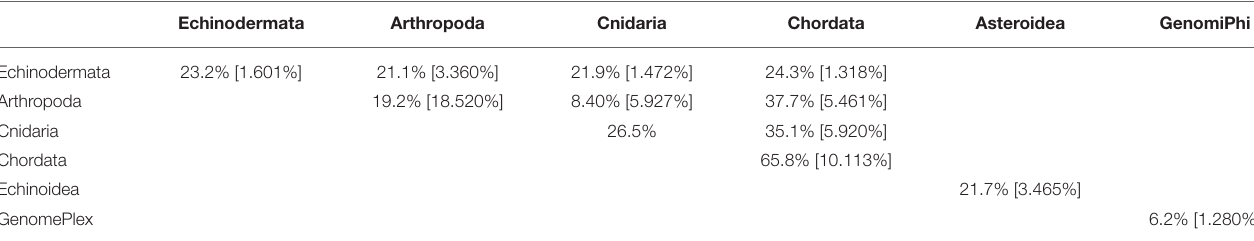
TABLE 4 | Pair-wise matrix of mean similarity and standard error (in brackets) of non-bacteriophage viromes within and between host phyla, between asteroids and echinoids, and between GenomePlex and GenomiPhi prepared libraries (from Pyura chilensis urochordate